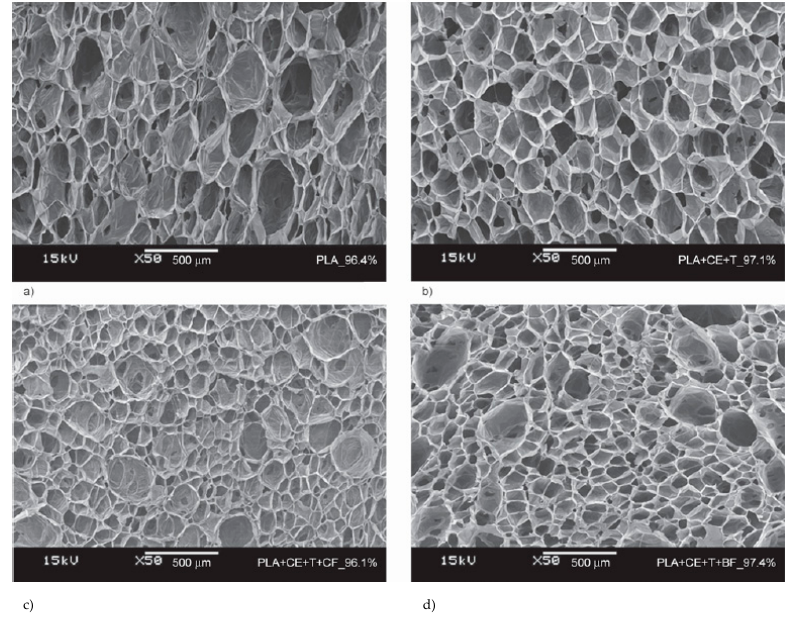
Figure 36. SEM micrographs of the cell morphologies obtained for highly expanded ( ε > 95%) PLA foams. ( a ) PLA, ( b ) PLA + CE + T, ( c ) PLA + CE + T + CF, and ( d ) PLA + CE + T + BF. Reprinted from Bocz et al. [150] with permission from Express Polymer Letters.